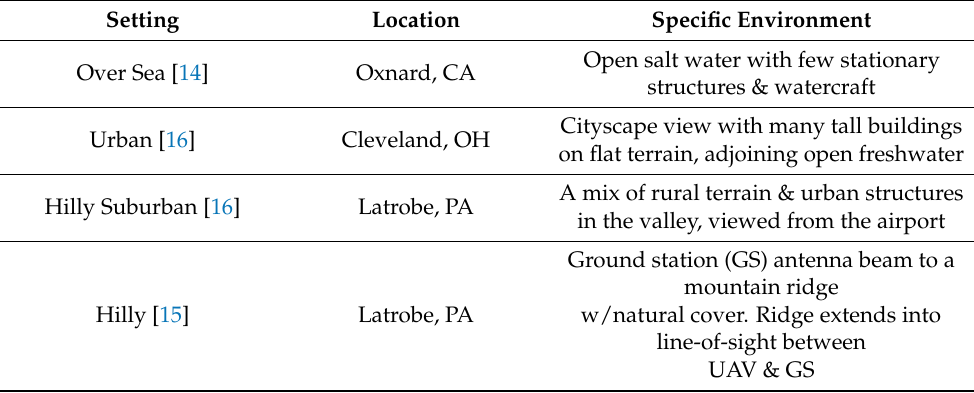
Figure 1. Classification of A2G propagation topography [11]. Table 1. Examples of A2G channel measurement environments [14–16].